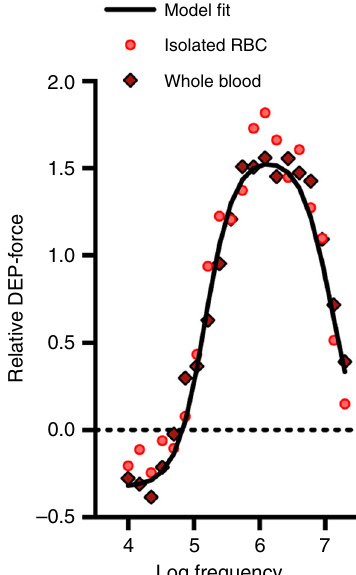
Fig. 6 Dielectrophoretic properties of acutely sampled whole human blood. Comparison of DEP spectra produced from isolated RBCs compared with whole blood from the same donor (representative spectra from a single donor are shown). Isolated RBCs were prepared as described and tested immediately following isolation. DEP model fi t parameters showed no signi fi cant variation ( p > 0.05 RM one-way ANOVA for sample type effect, df = 2, F = 3.51) between the isolated and whole blood samples, meaning that DEP may have diagnostic utility as an acute diagnostic marker for human circadian